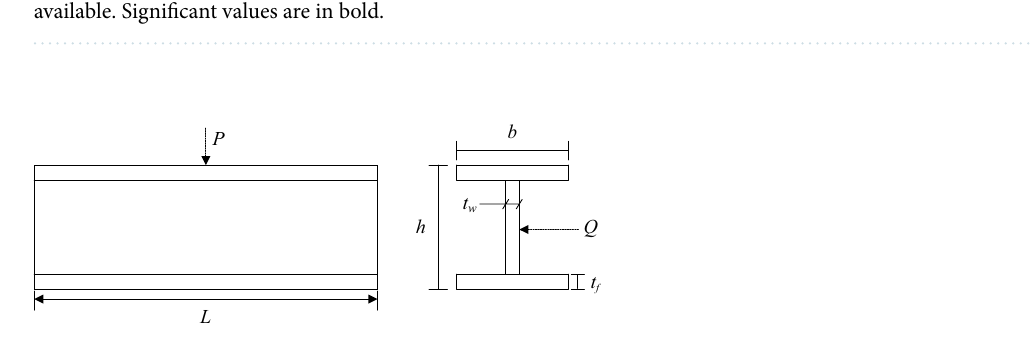
Figure 10. The vertical deflection of an I-beam.